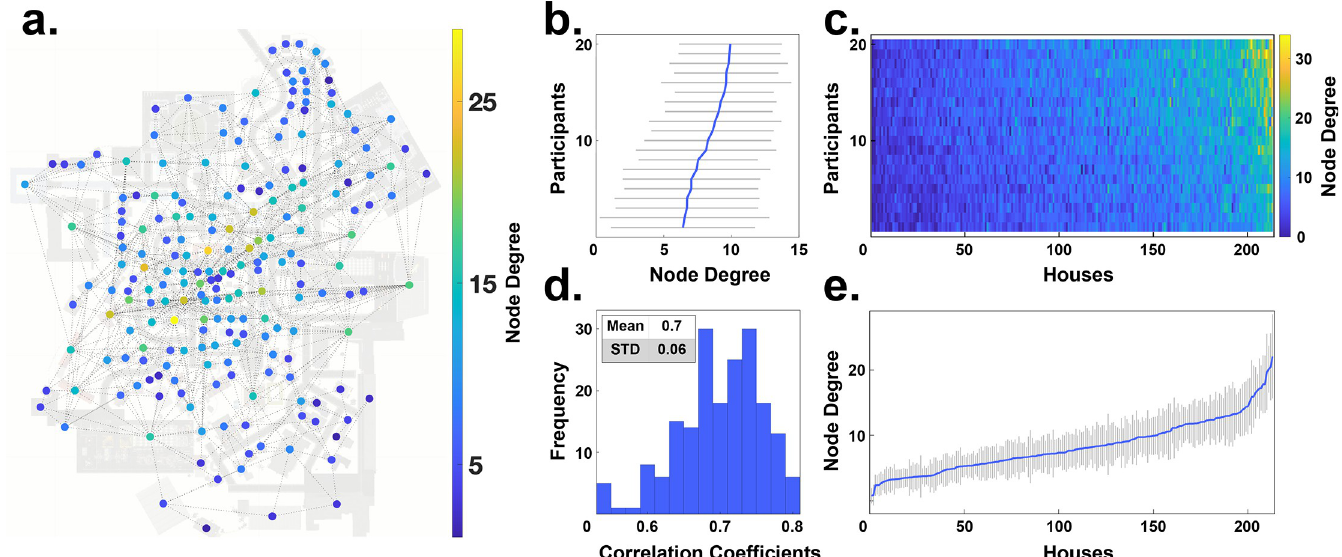
Fig 5. Node degree centrality. (a) The graph of one participant is visualized on top of the map of Seahaven. The nodes were colored according to their respective node degree centrality. (b) The individual mean node degrees of all participants (blue line) and their respective standard deviation (grey lines) are depicted sorted by increasing values. (c) A pseudo 3D plot color coding the node degree of every house (abscissa) for every participant (ordinate). The houses are sorted so that the average node degree value increases along the abscissa. Similarly, the participants are sorted, so that the average node degree increases along the ordinate. The marginals of this plot result in the panels b and e. (d) The distribution of the pairwise inter-participant correlation coefficients of the node degree values of all houses. (e) The mean node degree of each house sorted according to the mean node degree along the abscissa (blue line) and their respective standard deviations (grey lines).